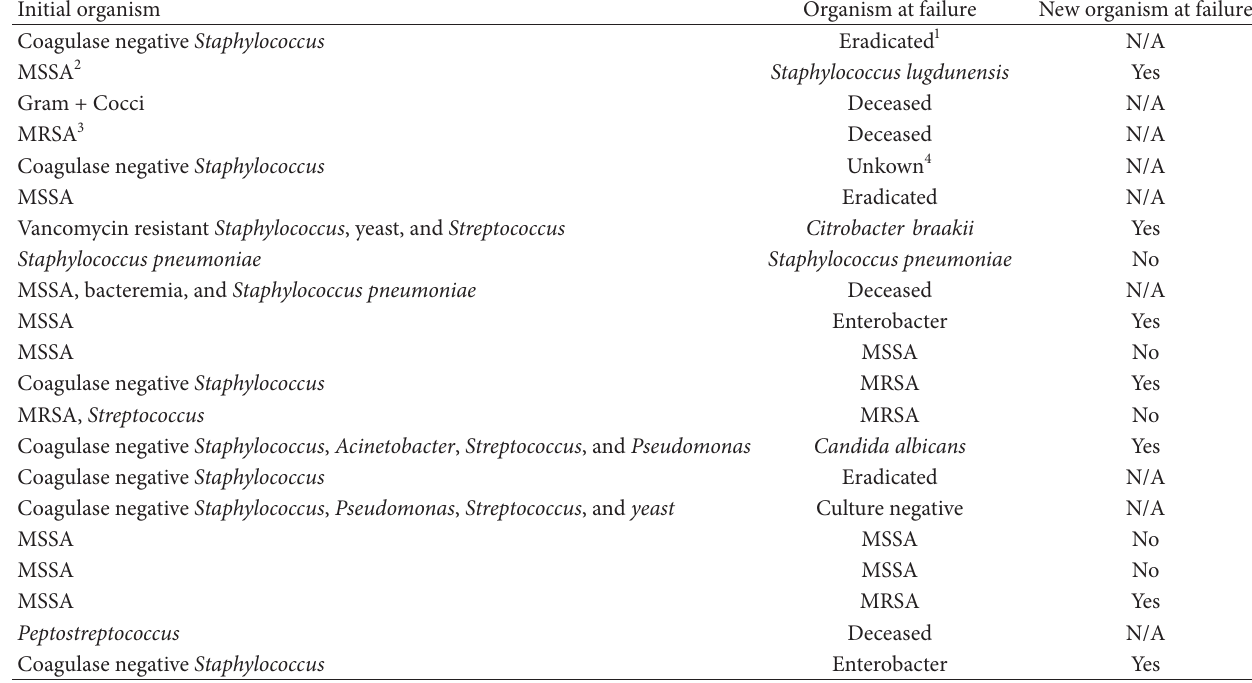
Table 3: Bacteria present at time of initial surgery and at time of failure.